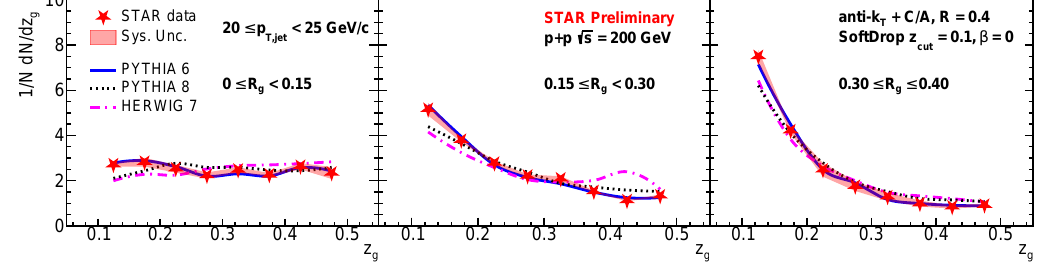
Figure 4: Fully unfolded z < p < 25 GeV / c in p + p collisions at T,jet